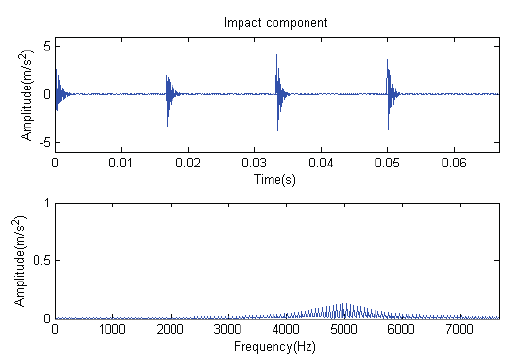
Figure 16. Impact component.